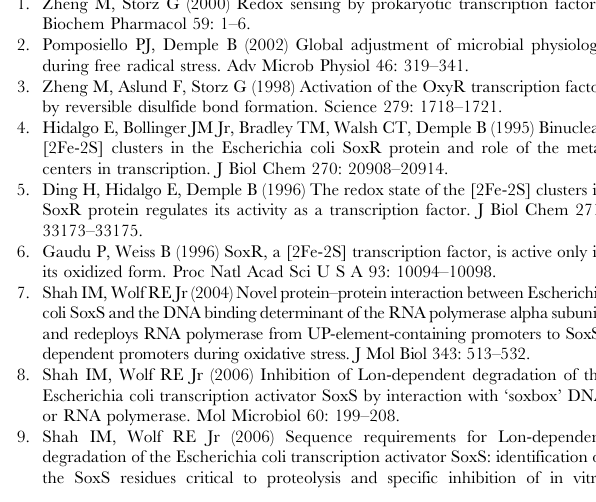
results for all 50 clusters.